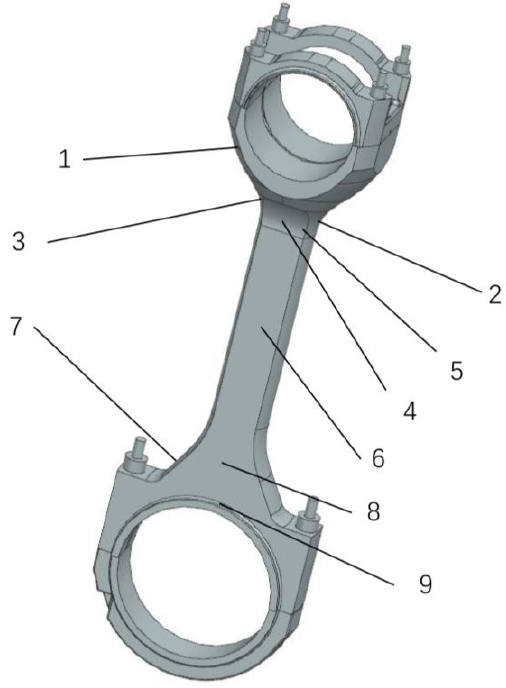
Figure 28. Pasting position of strain gauge.